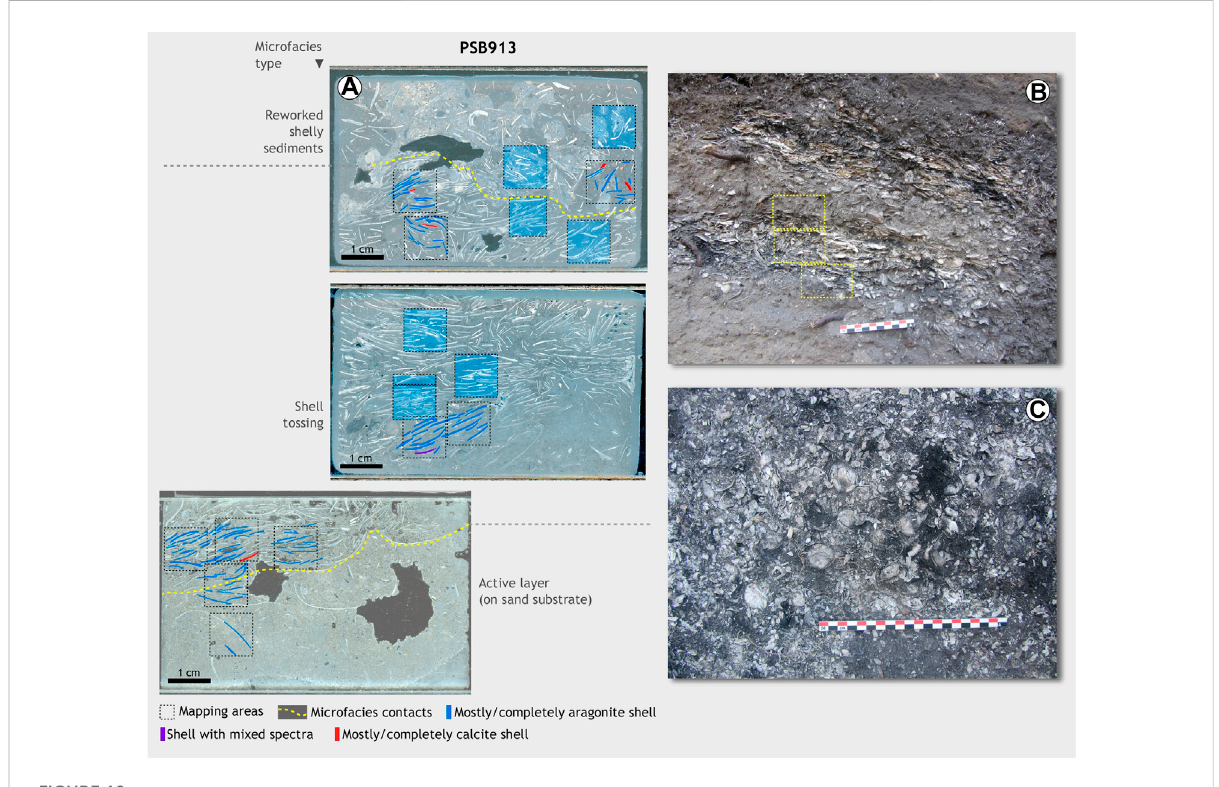
FIGURE 10 Sample PSB913. (A) Scans of three thin sections produced from the sample, showing individual shells ’ overall mineralogy obtained through micro FTIR; rectangles with bluish fi lter indicate that all shells in the map are aragonitic. (B) Close-up of the fi eld pro fi le with the direct tossing depositsandreworkeddepositsinterstrati fi ed;notetheabsenceofheatedsubstrateoranycontainmentfeaturesforcombustion;thedashedyellow rectangles indicated the approximate provenience of the thin sections. (C) Plane aspect of the direct tossing deposit interpreted as immediate discard of roasting residues; note the abundance of charcoal and the integrity of shells that in general revealed no mineralogical thermal